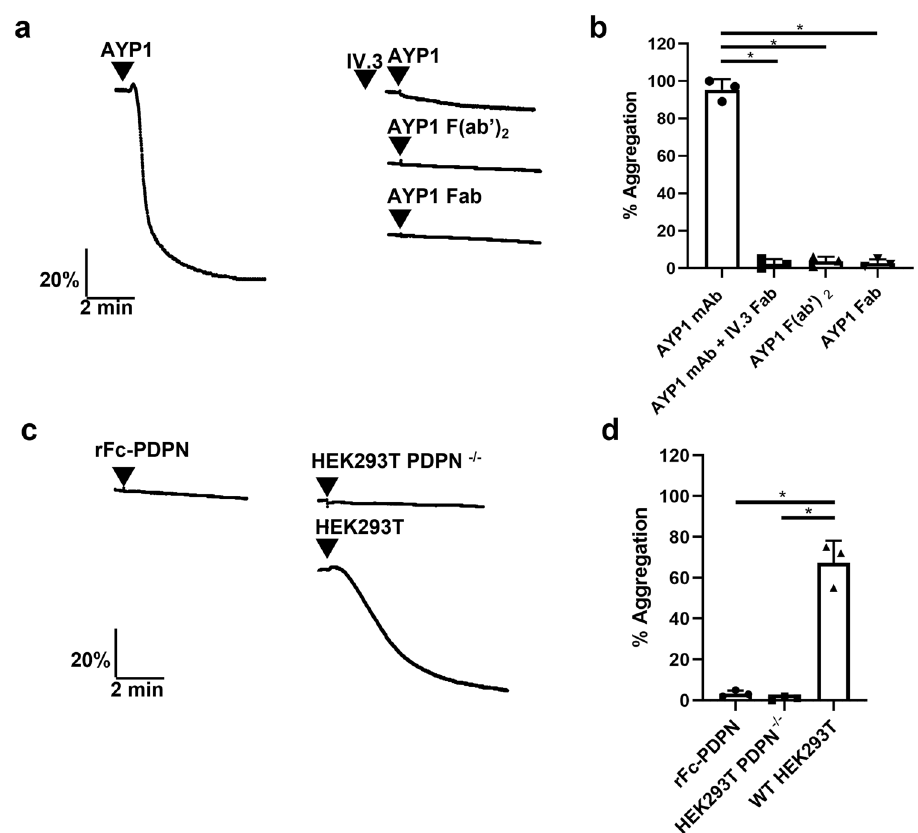
Fig. 4 Divalent AYP1 and podoplanin do not activate human platelets. Platelet aggregation was monitored by light transmission aggregometry at 37 °C with constant stirring at 1200 rpm for 5 mins. a Representative traces of human platelet aggregation (2 × 10 8 platelets/ml) induced by monoclonal antibody (mAb) AYP1 (66 nM) in the absence and presence of the anti-Fc γ RIIA IV.3 Fab (30 µ g/ml), AYP1 F(ab ’ ) 2 (66 nM) and AYP1 Fab fragments (66 nM). Platelets were preincubated with IV.3 Fab for 10 min at 37 °C prior to stimulation. b Percentage of platelet aggregation induced by mAb AYP1 or AYP1 Fab fragments ( n = 3 biologically independent experiments). c Representative traces of platelet aggregation following incubation with recombinant Fc- podoplanin (rFc-PDPN,136 nM), HEK293T PDPN − / − cells (5 × 10 5 cells) or wild-type HEK293T cells (5 × 10 5 cells). d Percentage of platelet aggregation induced by rFc-PDPN, HEK293T PDPN − / − cells or wild-type HEK293T cells ( n = 3 biologically independent experiments). Signi fi cance was measured using one-way ANOVA with a Bonferroni post-hoc test where P ≤ 0.05. Data presented as mean ± high-expressing DT40 cells; (ii) a tetravalent nanobody, LUAS-4 These results demonstrate that ligand valency, receptor density or LUAS-2-Fc, functions as an agonist in human platelets and Syk regulate receptor clustering and show that divalent showing that more than two epitopes are required for activation ligands can act as antagonists or agonists depending in part on of human platelets; (iii) CLEC-2 is expressed as a mixture of the receptor density. Not only will an increase in receptor density monomers and dimers in transfected cell lines and platelets and drive a bigger signal, but it will also increase the proportion of that increasing expression of CLEC-2 drives dimerisation; (iv) receptor dimers enabling divalent ligands to crosslink dimers and divalent and tetravalent ligands but not monovalent ligands drive form larger clusters of CLEC-2. dimerisation/oligomerisation of CLEC-2; (v) dimerisation/oligo- The antagonist and agonist activity of the divalent nanobody in merisation of CLEC-2 is regulated by the tyrosine kinase Syk. human platelets and humanised CLEC-2 mouse platelets,